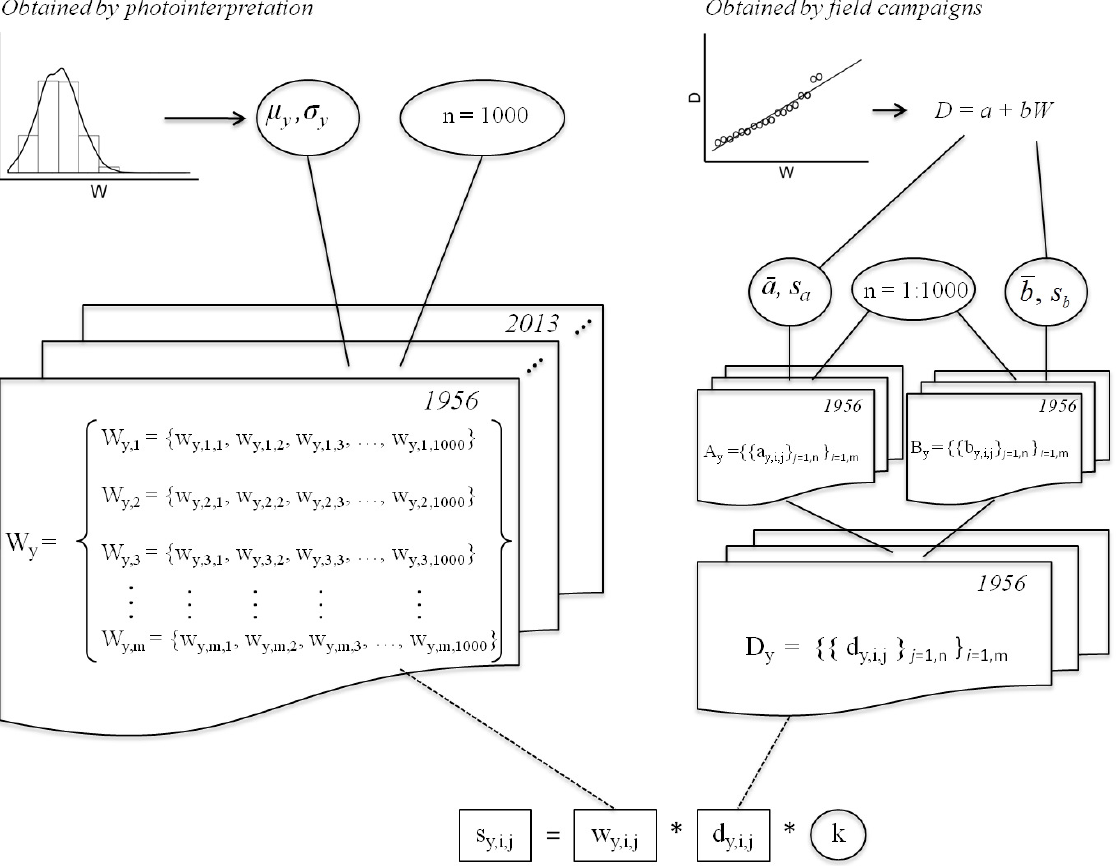
Figure 5. Conceptual scheme of the Monte Carlo simulation processes conducted to generate gully widths ( w y,i,j : single simulated width for a given segment and year; W y,i : set of 1000 simulated widths for a given segment and year) and depths ( d y,i,j : single simulated depth for a given segment and year; D y,i : set of 1000 simulated depths for a given segment and year) and to calculate the cross section ( S y,i ) for each gully segment and year. k is a shape factor for the gully cross section, m is the number of gully segments, n is the number of simulations, and a and b are fitted linear regression coefficients of the depth–width relation, with respective means ( a , b ) and standard deviations ( s a , s b